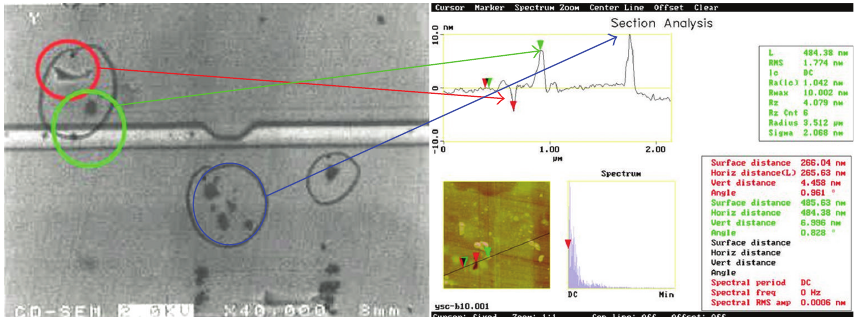
Figure 1: (a) Scanning electron microscopy (SEM) images of black spots, obtained with Hitachi S4800 high resolution SEM with Vacc 2.0 kV, × 40K. (b) Atomic force microscopy (AFM) images of the corresponding black spots from the SEM images, obtained with PSIA AFM from PARK Company, Korea, using tapping mode and a scan size of 10 × 40 𝜇 m.